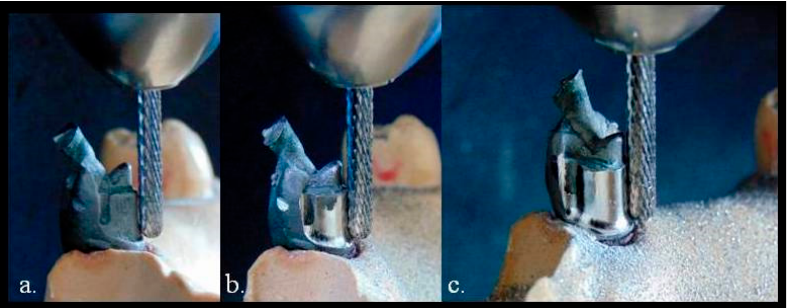
Figure 2. ( a ). The casting of P structure before milling; ( b ). The P structure during milling; ( c ). The surface of the vertical wall rectified by milling.